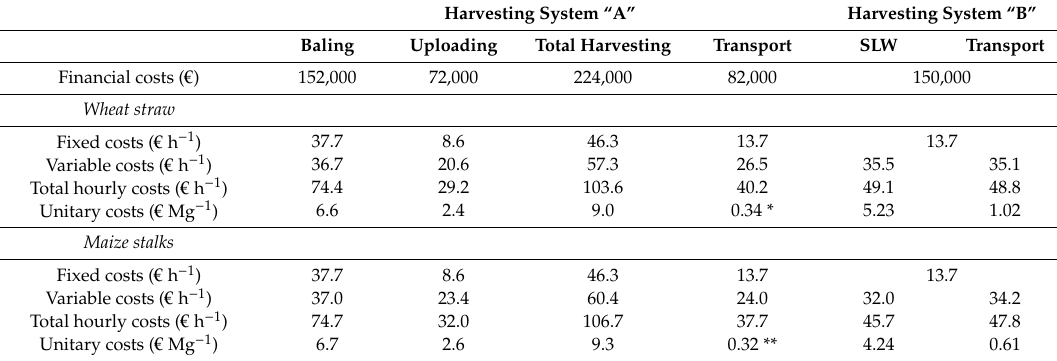
Table 4. Cost analysis of the harvesting system “A” (HS-A) and harvesting system “B” (HS-B) for wheat straw and maize